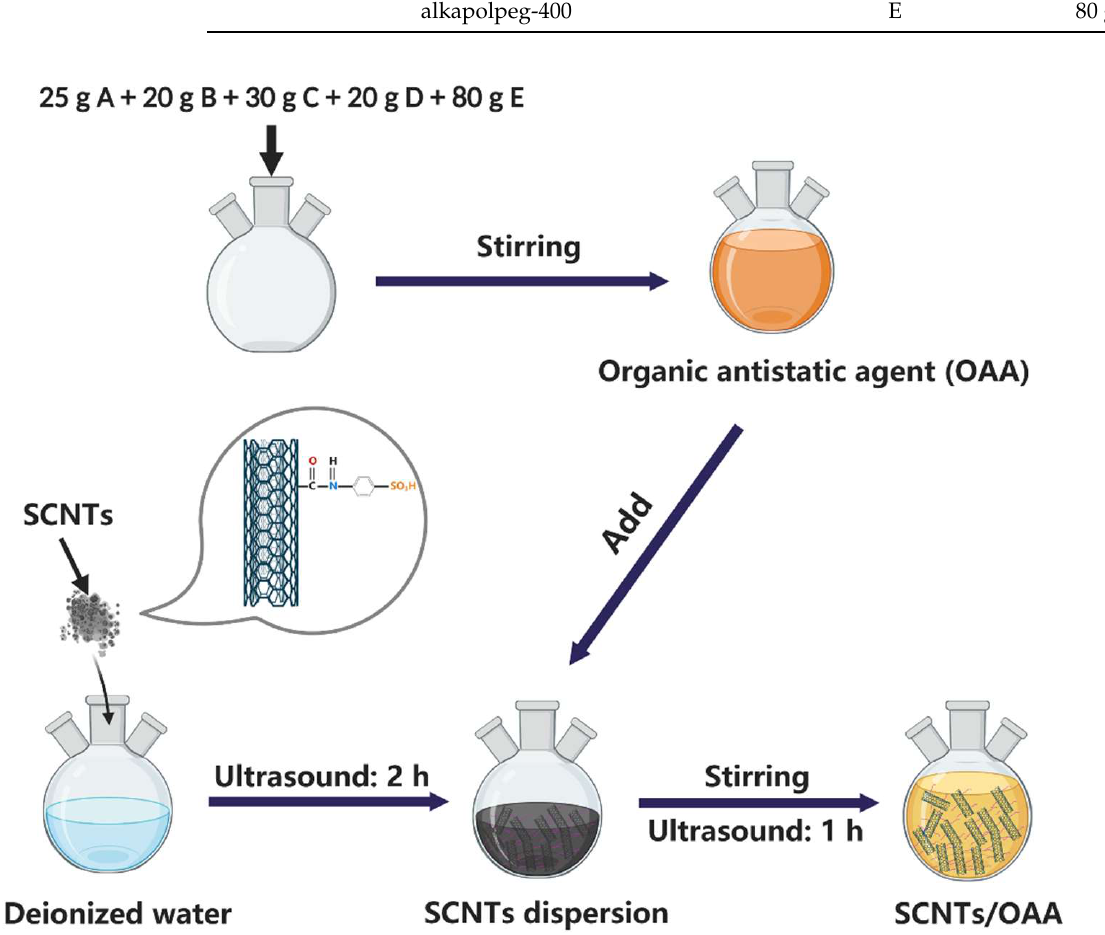
Figure 2. The preparation procedure of SCNTs/OAA.